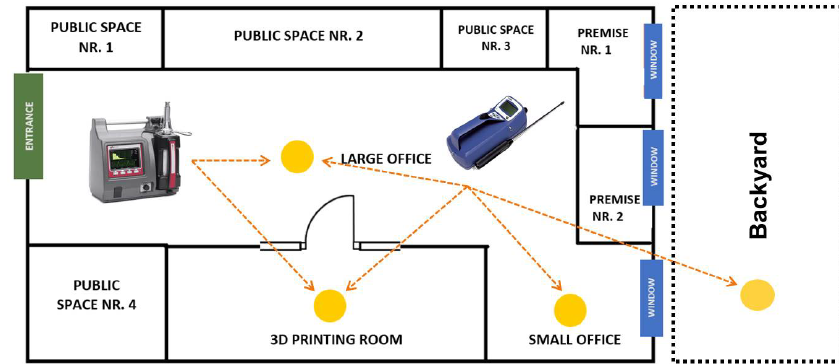
Fig. 2. Schematic figure of the measurement